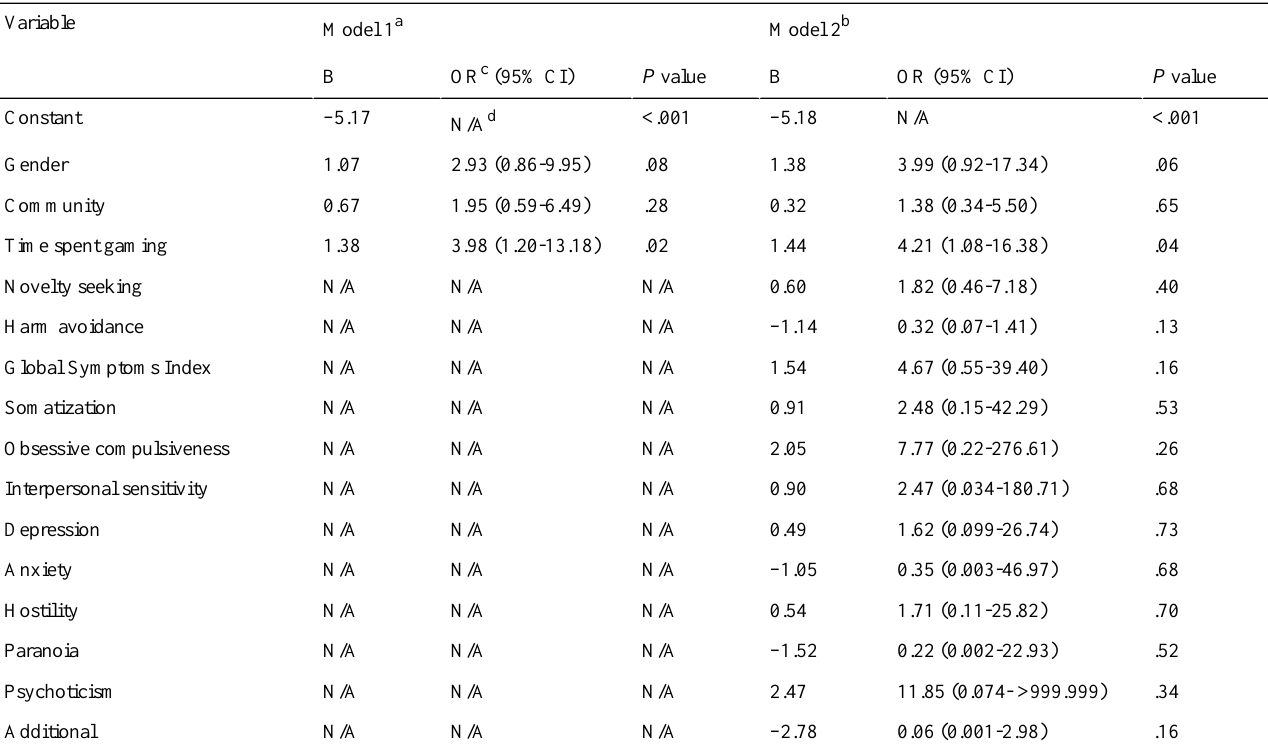
Table 5. Logistic regression analysis of demographics, temperament, and psychopathologies with internet gaming disorder (dependent